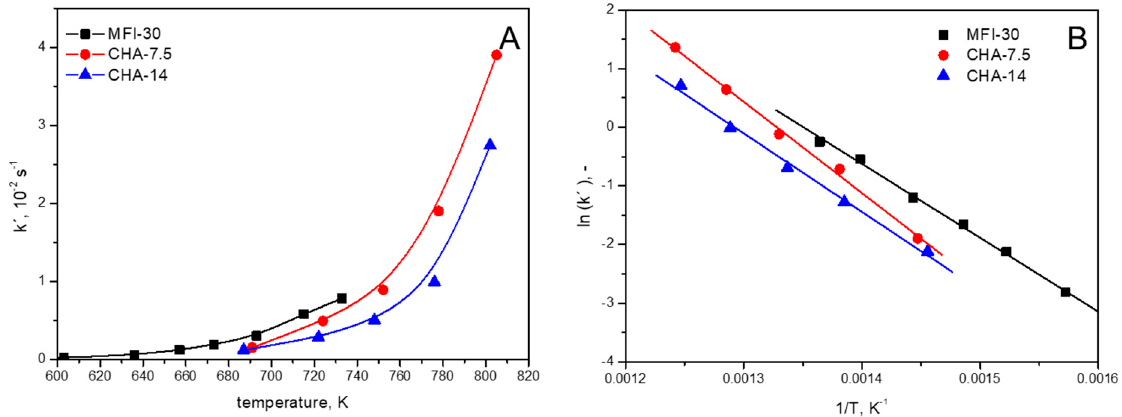
Figure 1. Rate constants of the H/D isotopic exchange between ethane (50 mbar) and deuterated zeolite as a function of temperature ( A ) and Arrhenius plot of the data from panel A ( B ).